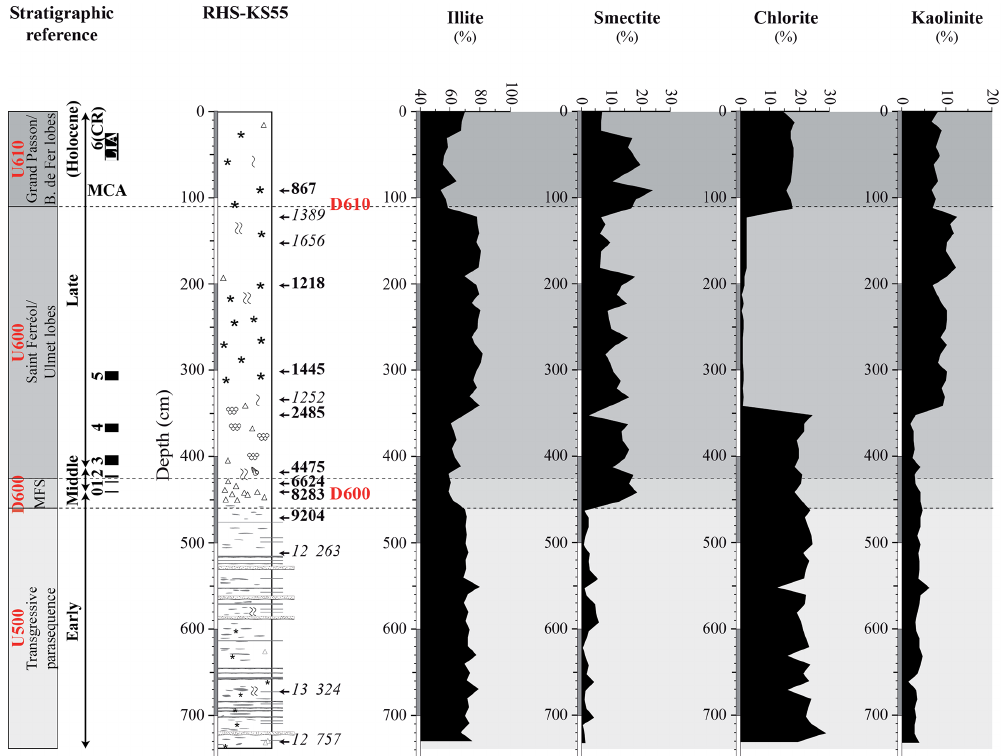
Figure 5. Distribution of the main clay minerals in core RHS-KS55. Correlations with seismic units and discontinuities are shown on the left side of the figure. The corresponding positions of seismic units and discontinuities (U500, U600, U610, D600, and D610) are also reported on the plots (gray bands and dashed lines). Black rectangles on the left side of the figure represent the most significant periods of climate deterioration (i.e., cold relapses (CRs)) during the